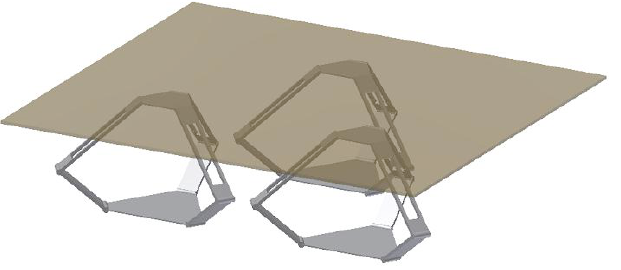
Figure 12: Schematic of the ball‐and‐plate system implementation Figure 15. Schematic of the ball-and-plate system implementation. Three Novint Falcon devices are arranged facing upwards and equally spaced. The plate rests on top of the three moving platforms. This way, the position of the moving platforms determines the tilt angle of the plate.